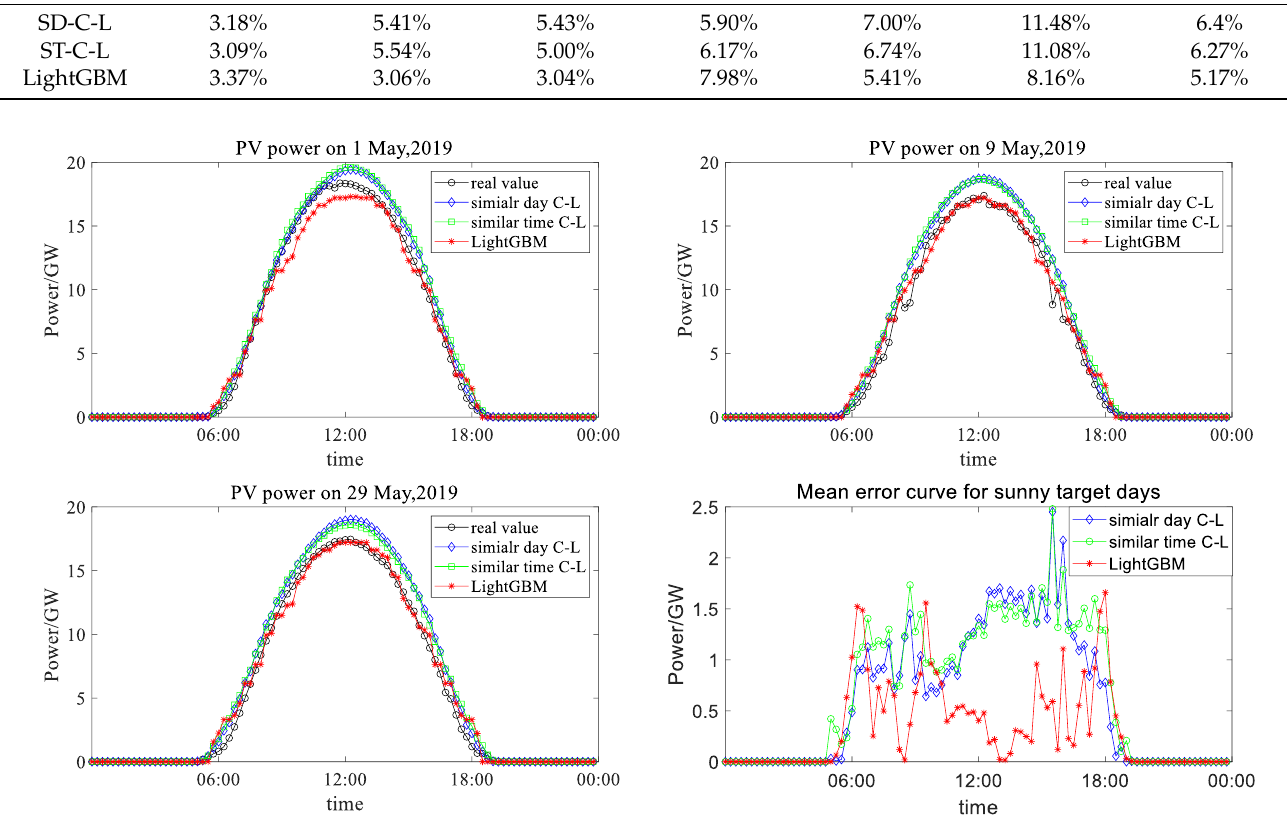
Figure 10. Predicted power and mean error curves for sunny target days.